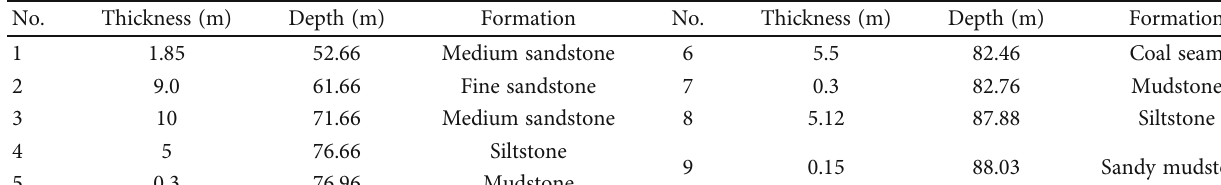
Table 1: Comprehensive histogram of working face